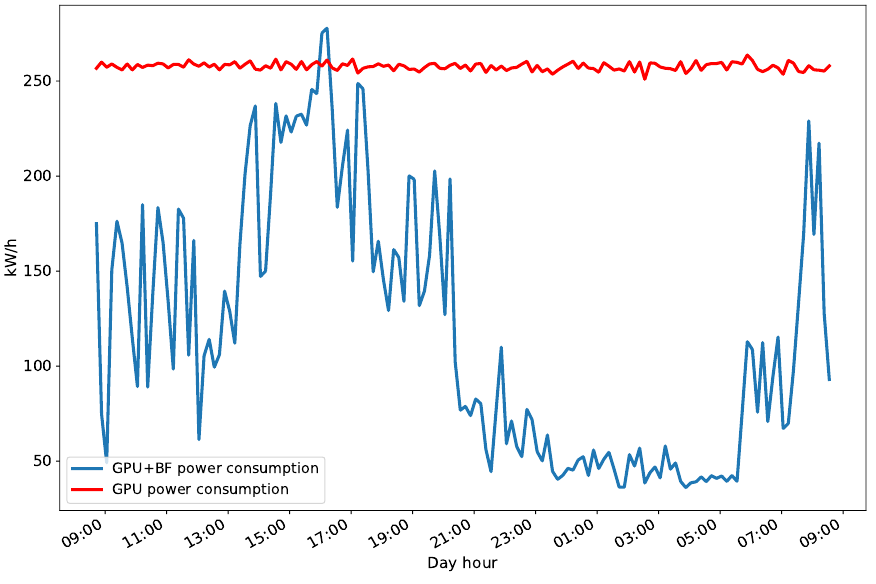
Figure 5. Energy consumption throughout the day.